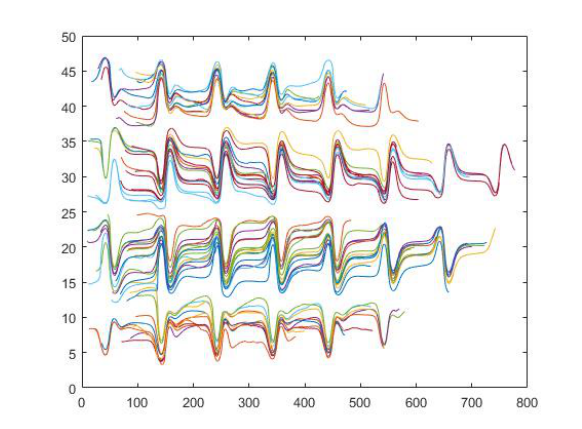
Fig. 16. Geometry C50, two different seedings, Y-coordinate position in relation to